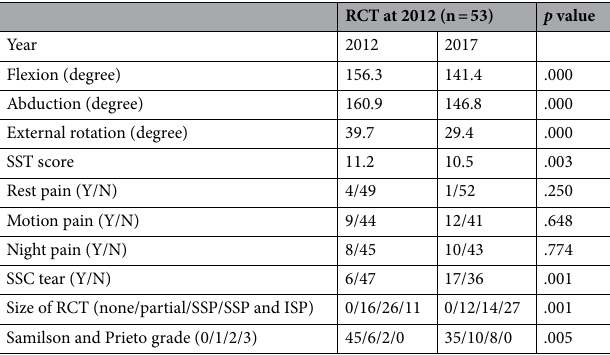
Table 3. Longitudinal changes in shoulders with RCT.